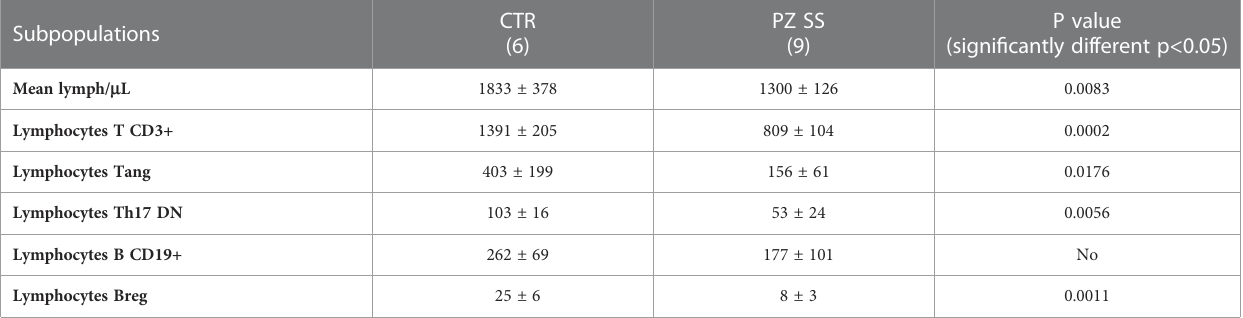
TABLE 1 Frequency (no. cells/µL) of immune subsets in the peripheral blood of the group of healthy subjects (CTRL) and patients with SS (PZ SS) at the time of collection. Subpopulations